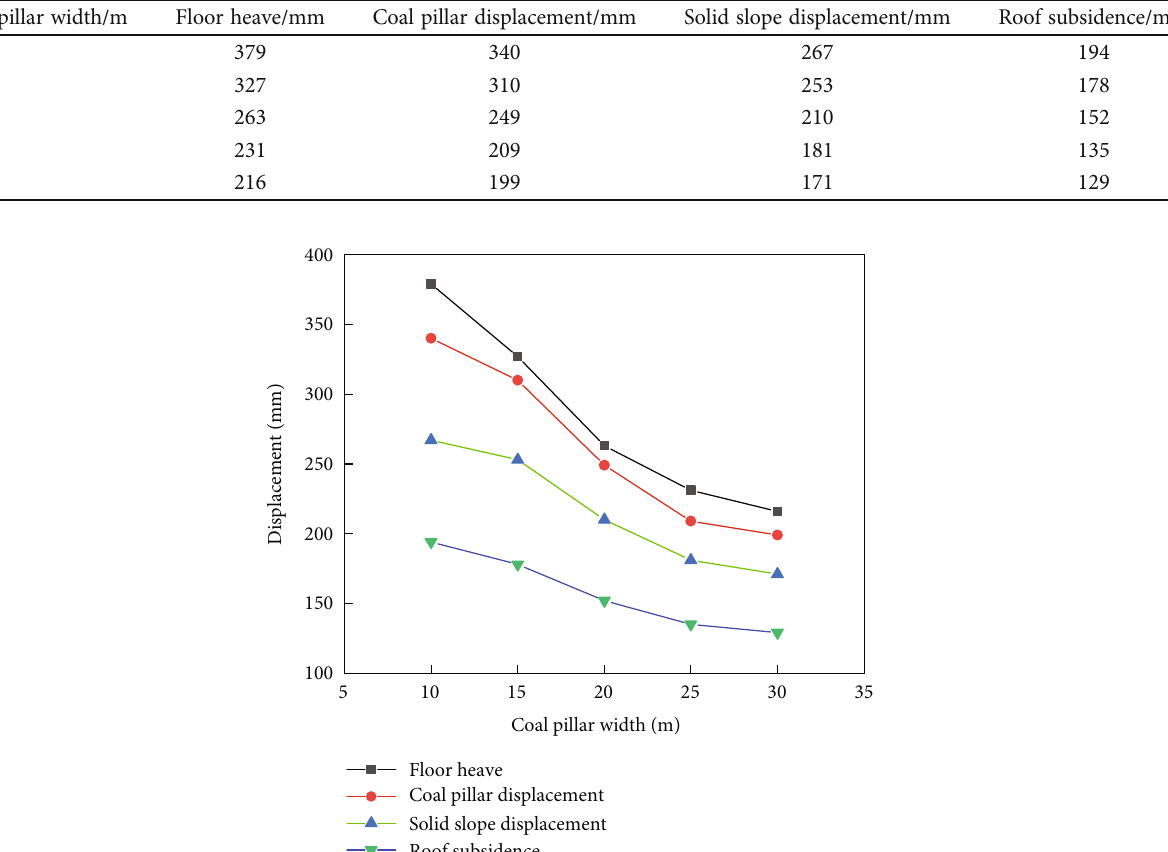
Table 2: Surface displacement of roadway with di ff erent pillar